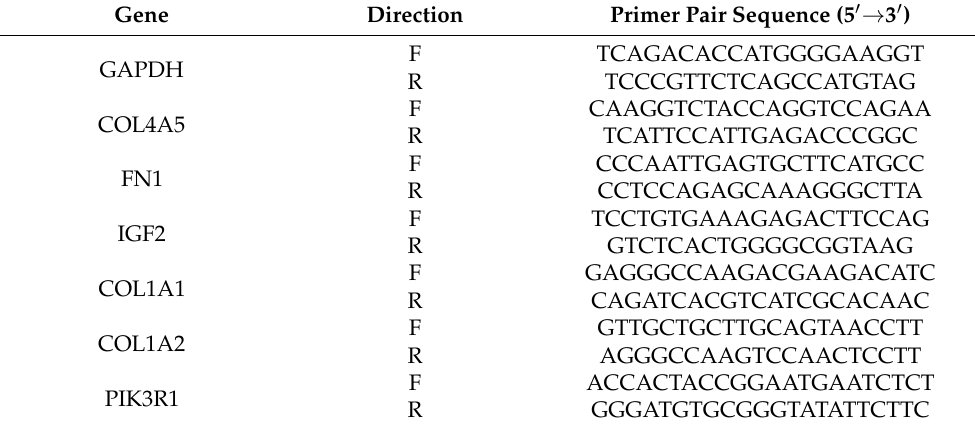
Table 2. Primer sequences for real-time PCR.